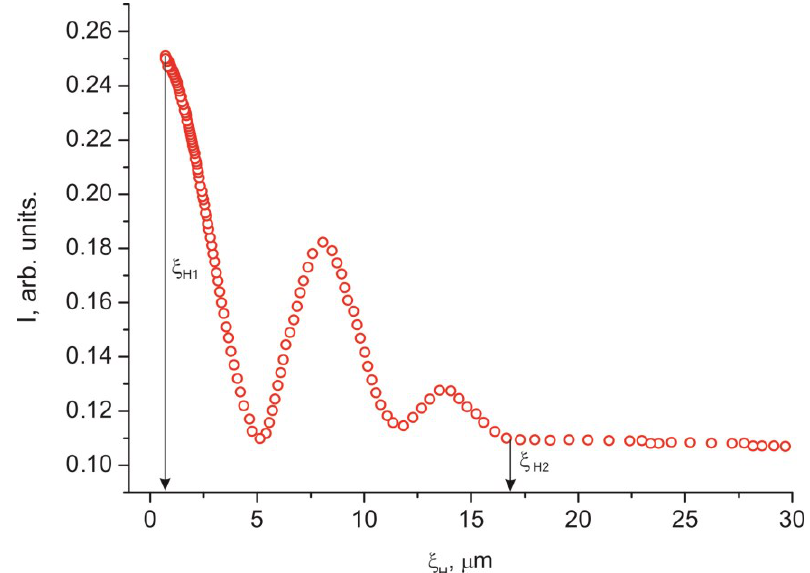
Figure 8. Intensity I of the laser radiation passed through the 30 µm thick planar 5CB layer with domains formed on the PC surface versus magnetic coherence length ξ from Figure 3. Lengths ξ threshold field and limit optical resolution